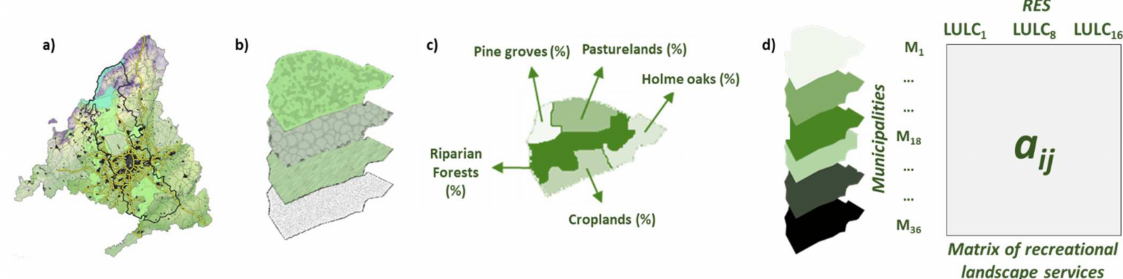
Figure 3. Scheme of the procedure for detecting recreational landscape services. ( a ) Spatial identification of the constituent municipalities of the rural-urban gradient studied (land units); ( b ) geospatial reclassification and selection of LULCs considered as RES proxies, at municipal level; ( c ) calculation in each municipality of the spatial cover (%) of selected LULCs; ( d ) each municipality of the rural-urban gradient is a row vector containing quantitative data (aij) of RES proxies (column data) in a matrix of recreational landscape